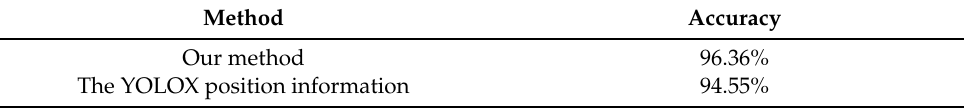
Table 1. Accuracy comparison of two feeding detection